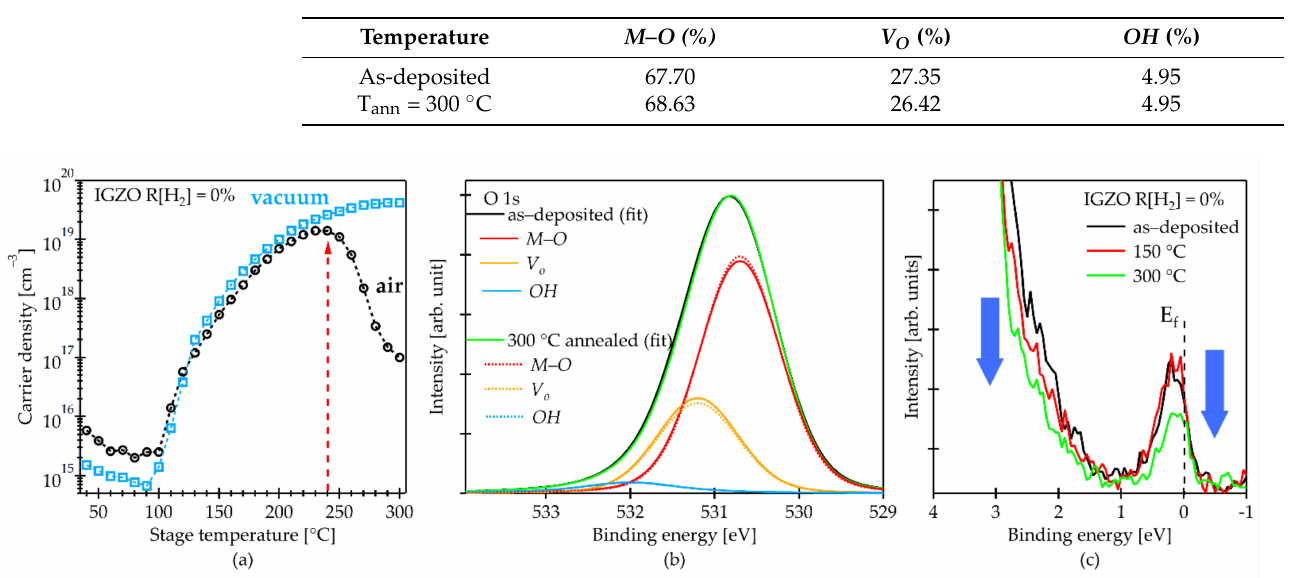
Table 2. Relative area ratio of the metal-oxygen ( M–O) , oxygen vacancies ( V O ) and oxygen-hydrogen ( OH ) of the conventional IGZO film before and after annealing in air for 1 h after deconvolution of O 1s spectra.